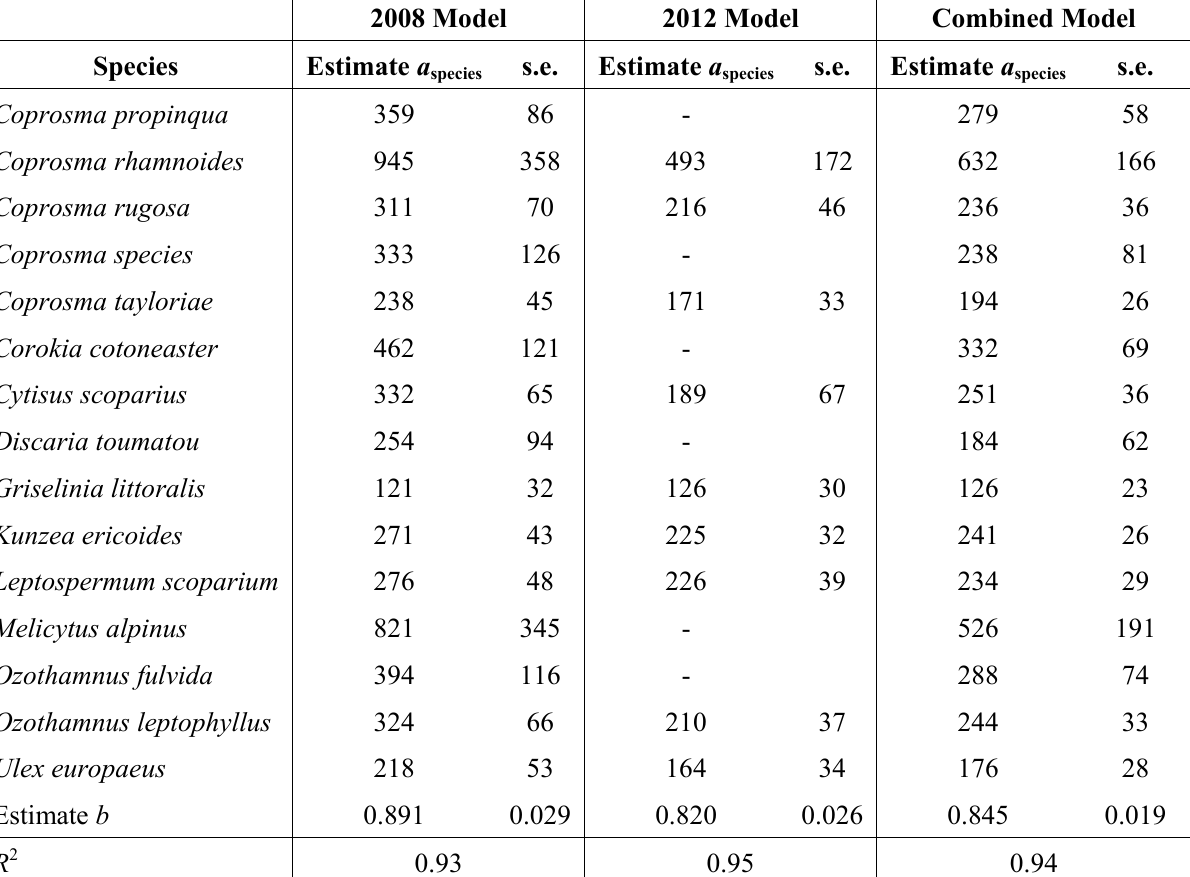
Table 2. Coefficients of allometric models for estimating dry weight (kg) of each shrub plant from summed basal area of stems (m 2 ) and height of longest stem (m) using DryWeight = a ( BA × Height ) b . Model coefficients were obtained using the SAS species GLIMMIX procedure while R 2 values are reported for the log-log regression